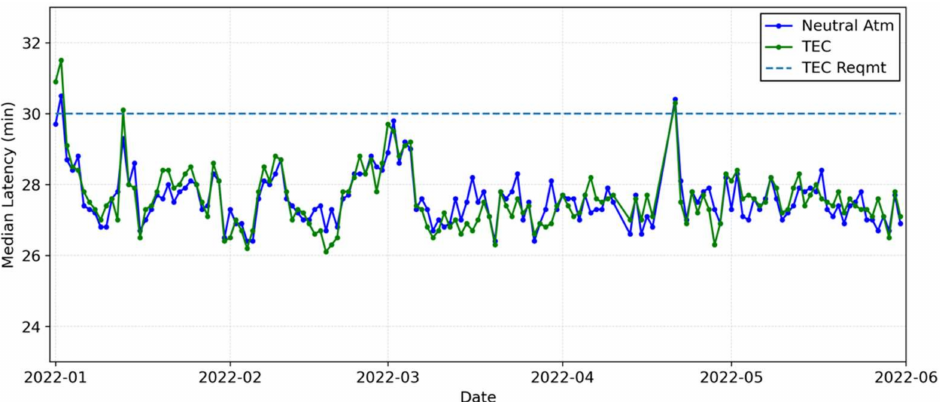
Figure 5. Data product latency in 2022. The 45 min neutral atmosphere requirement line is not shown. Unexplained outlier data on 12 April 2022 are